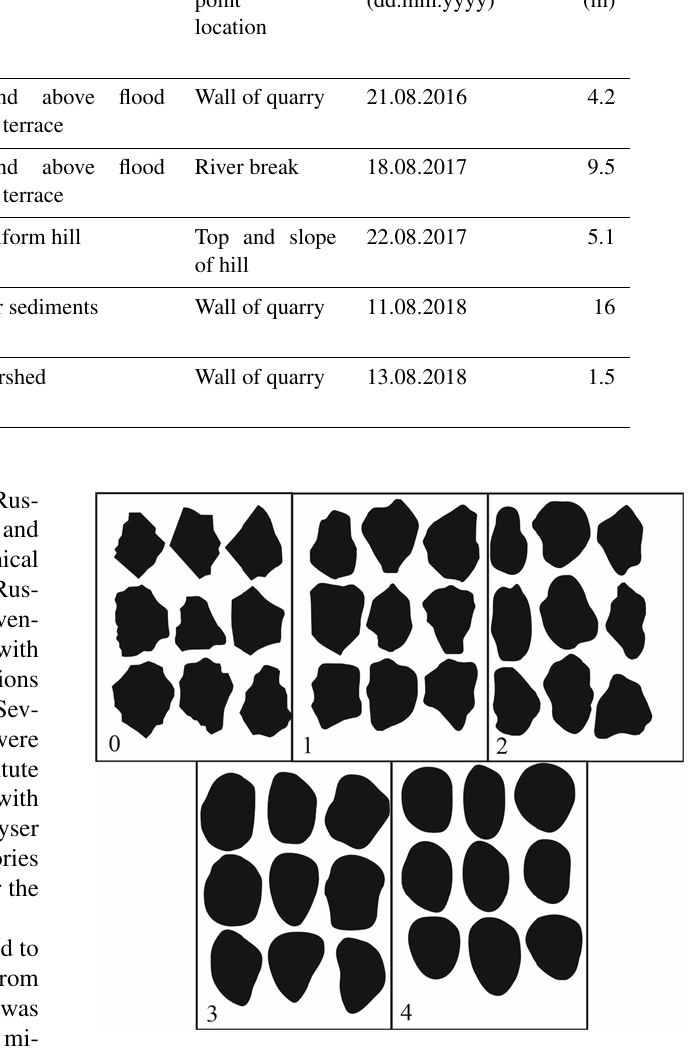
Figure 2. Patterns (Rukhin, 1969) 0 – 0, 1 – I, 2 – II, 3 – III, and 4 – IV are the classes of roundness (Khabakov,